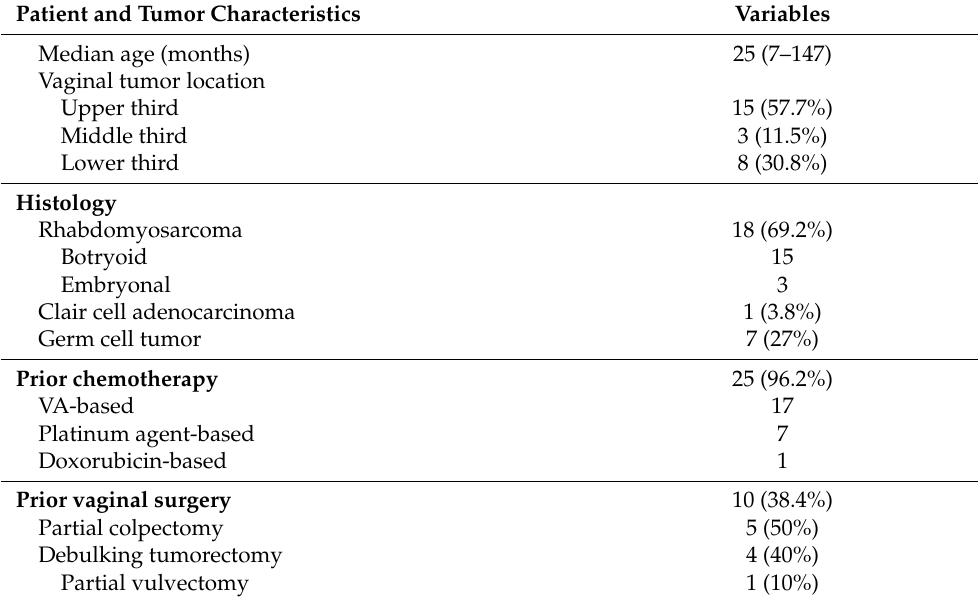
Table 1. Patient and tumor baseline